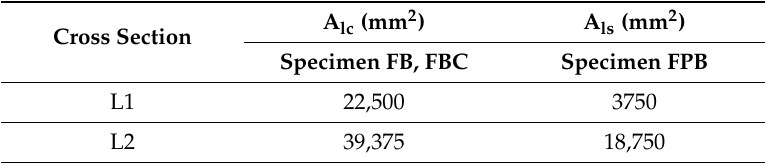
Table 3. Cross-section of each element for simplified model.